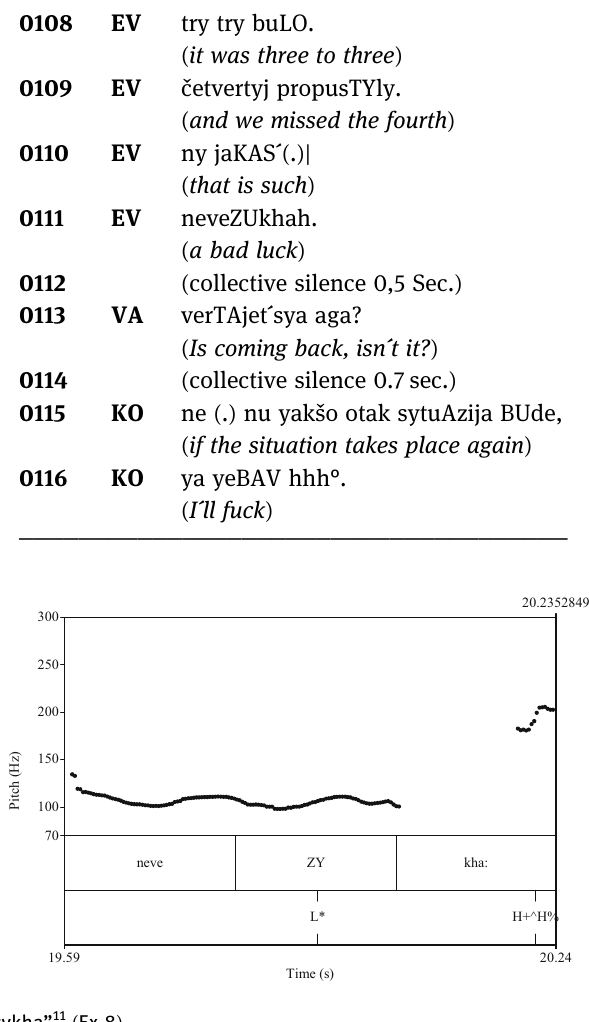
Figure 6: Praat fi gure “ nevezykha ” 11 ( Ex.8 ) .